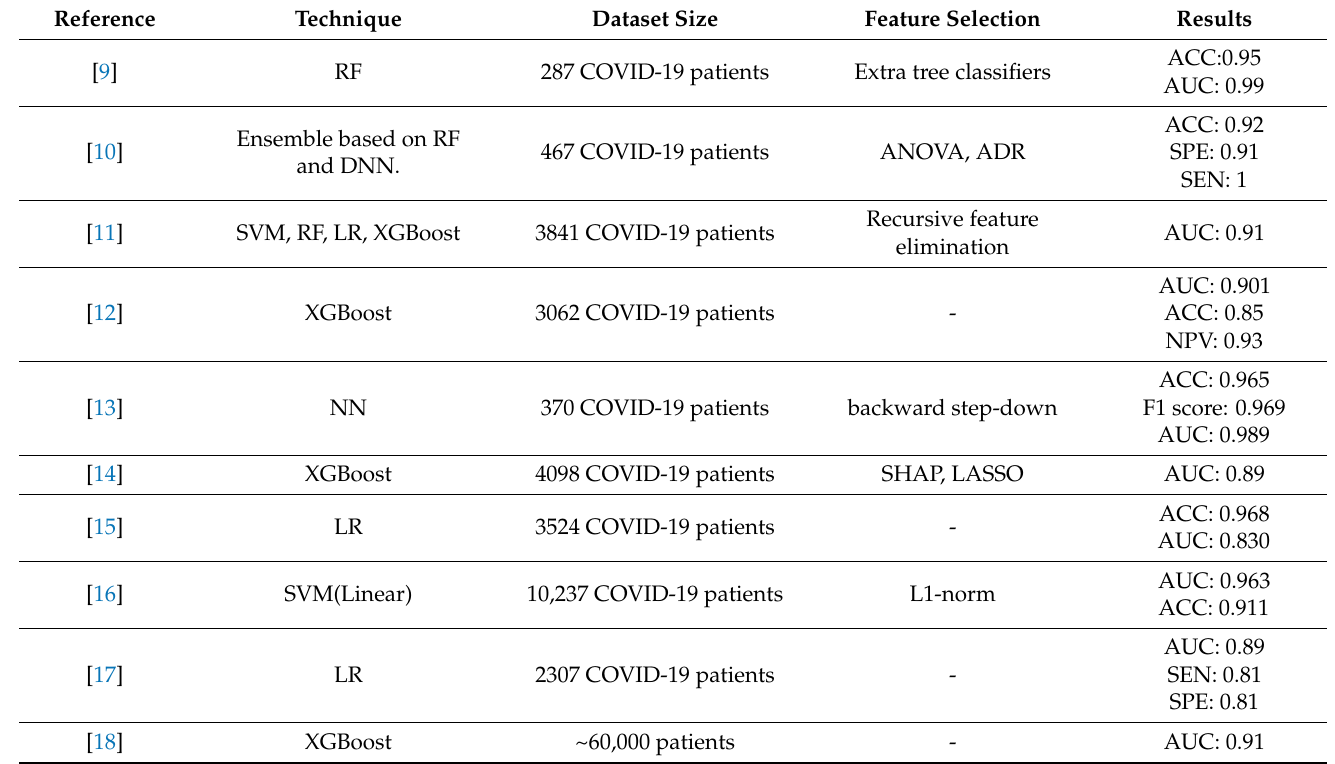
Table 1. Summary of related studies using machine learning